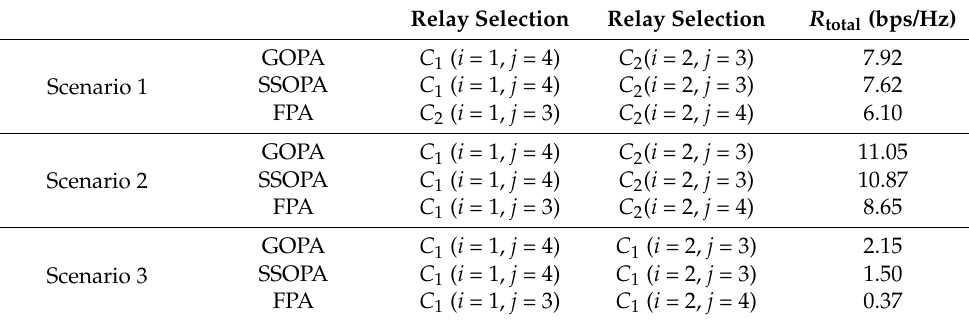
Table 5. Comparisons of three scenarios for